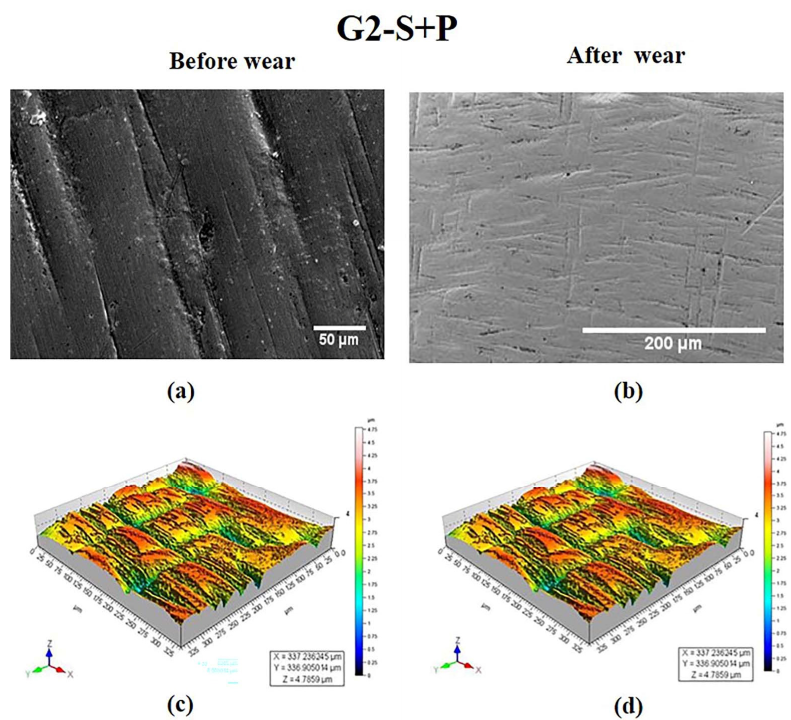
Figure 3. SEM images of specimen in G2 group at magnifications of ( a ) 50 µ m and ( b ) 200 µ m. 3-D surface morphology profile ( c ) before wear ( d ) after wear.